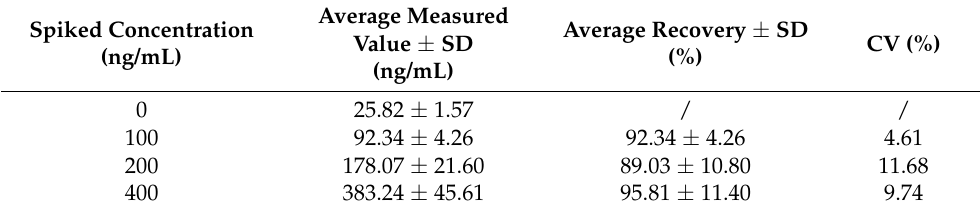
Table 5. Test of recovery of Cd (II) in food packaging materials ( n =